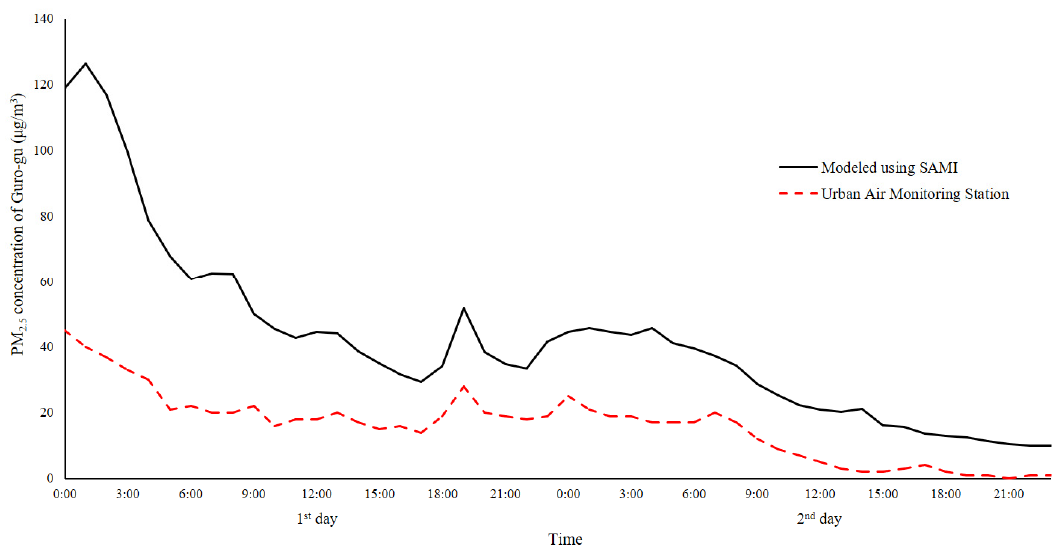
Figure 4. Comparison of outdoor fine particulate matter (PM 2.5 ) concentrations modeled by a sensor-based air monitoring instrument (SAMI) and measured by an urban air monitoring station over time. Atmosphere 2020 , 11 , x FOR PEER REVIEW